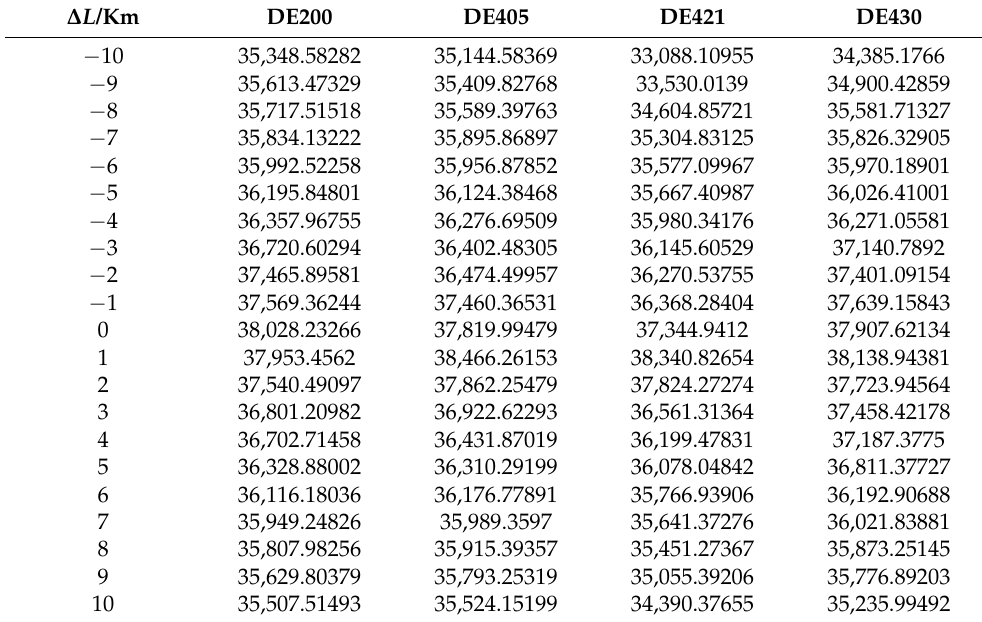
Table 6. χ 2 values of each ephemeris simulation